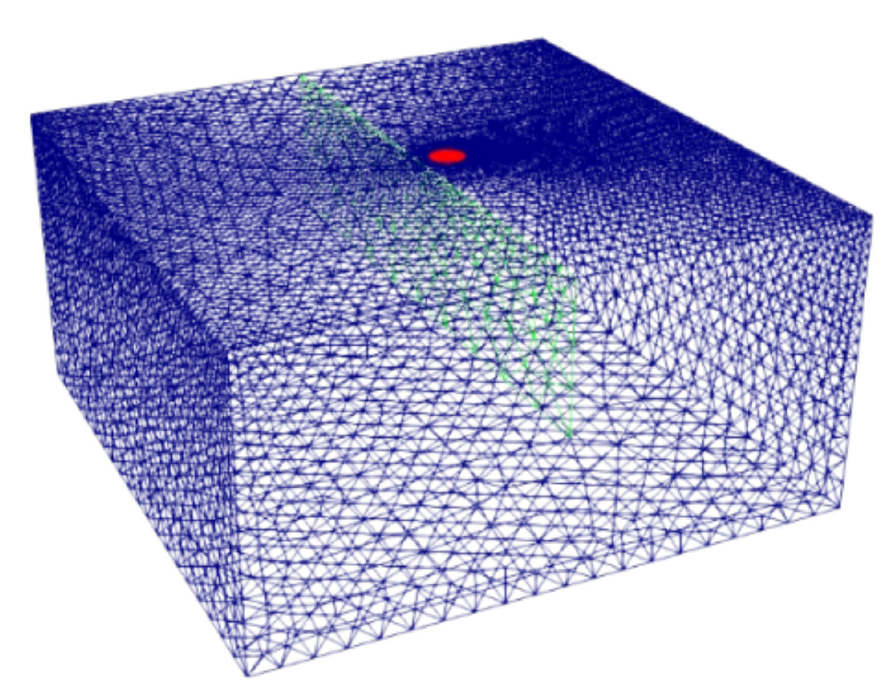
Figure 3. Triangulation of the investigated sample domain. The crack is depicted in green as a 2-D interface, whereas the laser heat supply is depicted as a red